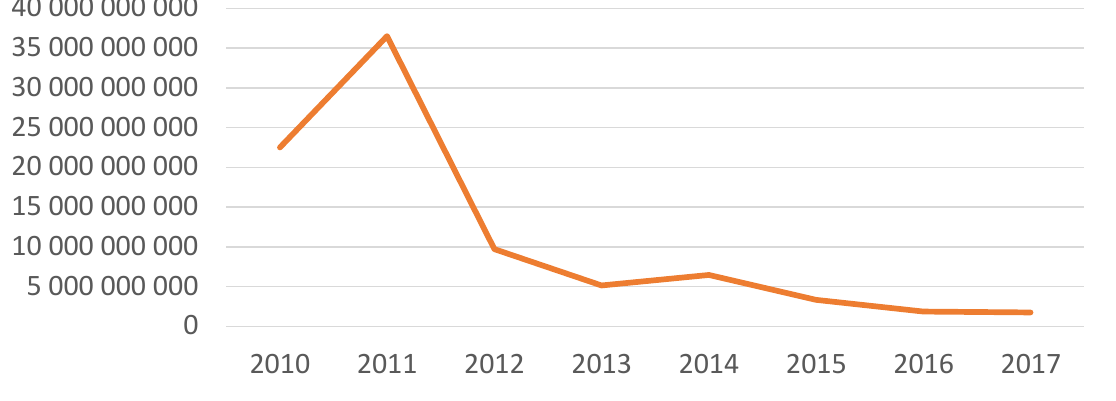
Figure 1. Trade volumes in the Ukrainian Exchange during 2010–2017 (UAH)